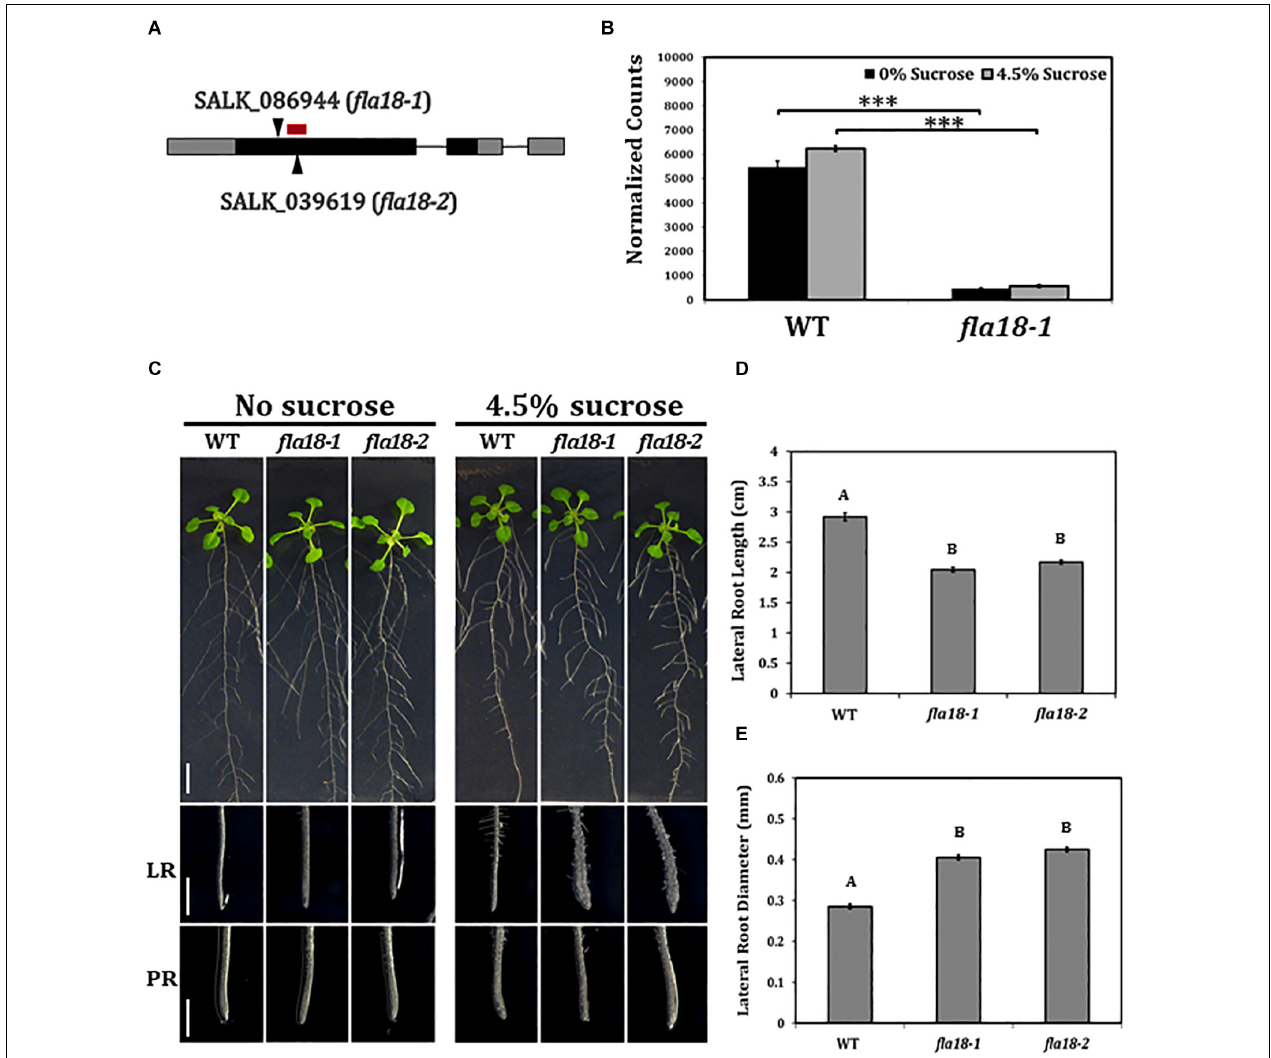
FIGURE 1 | fla18 mutants display conditional perturbation of root elongation. (A) Schematic presentation of the FLA18 gene as annotated by The Arabidopsis Information Resource, pinpointing the location of the T-DNA insertion in both alleles examined, i.e., fla18-1 (SALK_086944) and fla18-2 (SALK_039619). The red bar represents the location of the nCounter NanoString probe. (B) FLA18 gene expression at the primary root of the indicated genotypes. Seedlings were germinated on medium containing 1% sucrose, for 4 d, and then transferred to either sucrose-free or 4.5% sucrose-containing medium for 6 h. Gene expression was measured using the nCounter NanoString technology, in four biological replicates. Expression level is indicated in normalized counts, as calculated by the nSolver platform using GAPC, UBQ10, EF1a, F-BOX, and AP2 as reference genes. (C) Seedlings of the indicated genotypes were grown on sucrose-free MS medium for 4 days and then, transferred to either new sucrose-free MS medium or MS medium supplemented with 4.5% sucrose, for an additional 10 days. Whole seedlings (upper panel), lateral root tips (LR, middle panel) and primary root tips (PR, lower panel) were documented. Total lateral root length (D) and diameter (E) were measured 7 days after the transfer to restrictive conditions (MS plus 4.5% sucrose). Error bars represent SE. The results were analyzed through JMPpro13 for statistical analysis, applying Tukey’s HSD test ( B ; *** p < 0.0001 ) or a non-parametric comparison for all pairs using the Steel-Dwass Method ( D,E ; p < 0.0001 ). D and E, n = 10. Scale bars = 1 cm ( C ; upper panel) and 1 mm ( C ; middle and lower